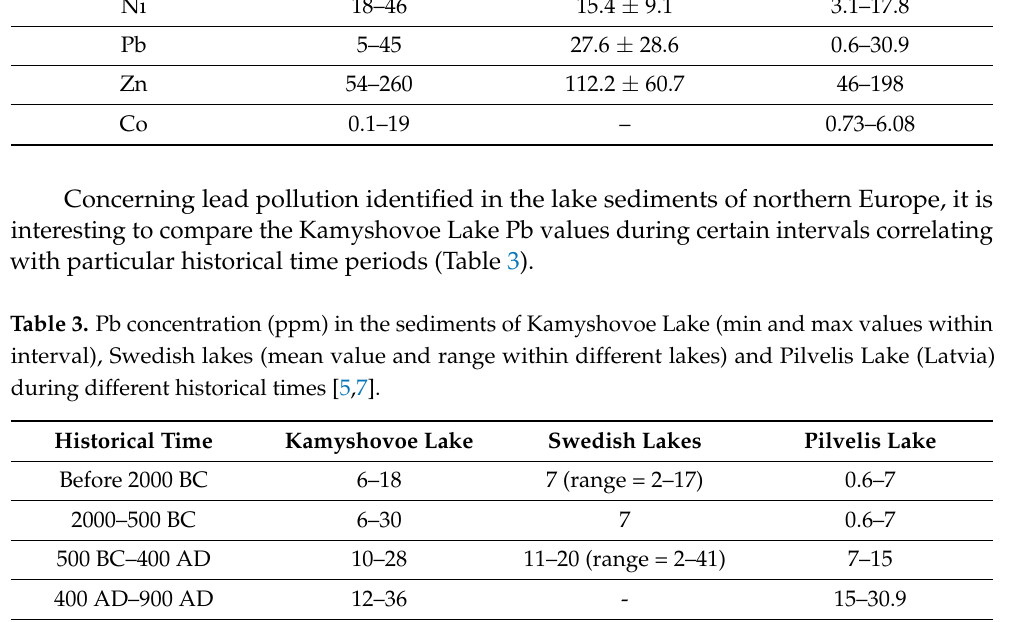
Table 2. Concentration (ppm) of metals in the sediments of Kamyshovoe Lake (interval 730–245 cm; min and max values), Suwalki Lakeland (Preindustrial interval 52–50 cm; median value and standard deviations) and Pilvelis Lake (interval 400–0 cm; min and max values) [7,33]. Element Kamyshovoe Lake Suwalki Lakeland Cu